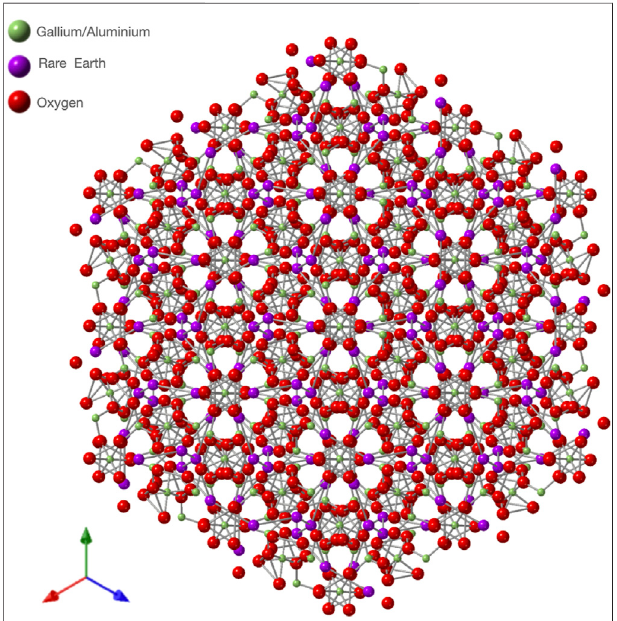
FIGURE 2 | (top) Rare earth gallium/alluminate garnet crystal structure viewed along the [1 1 1] direction.